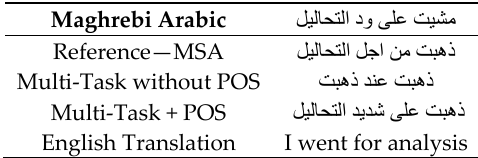
Table 7. Translation examples for Maghrebi.